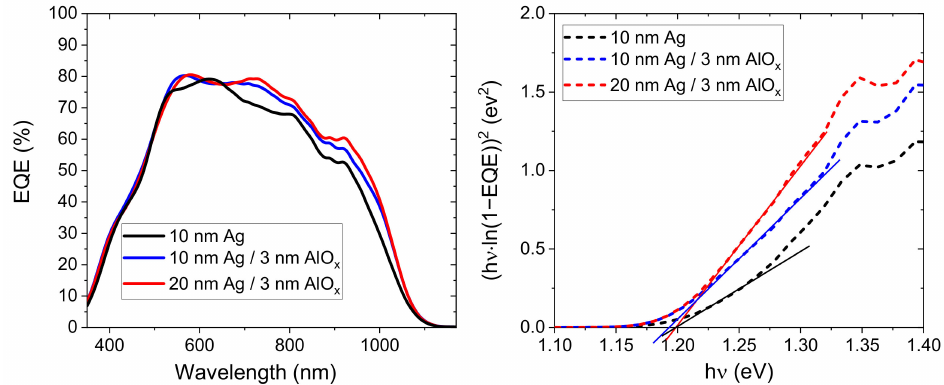
Figure 3. ( Left ) EQE of the Ag containing solar cells; ( right ) tauc plots from EQE